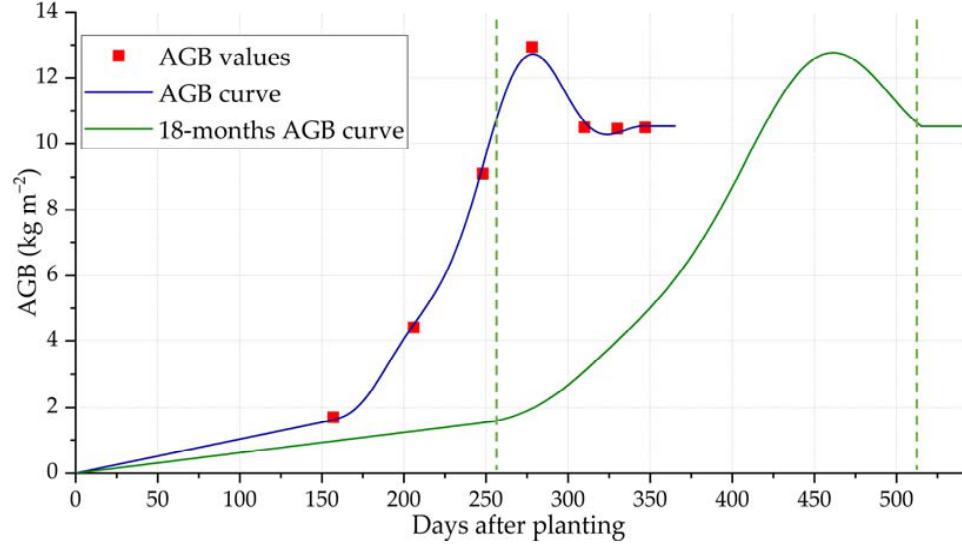
Figure 19. AGB curve based on the AGB values of the experimental area and the 18-month sugarcane AGB curve. The dotted lines indicate the limit of the piecewise-defined function.